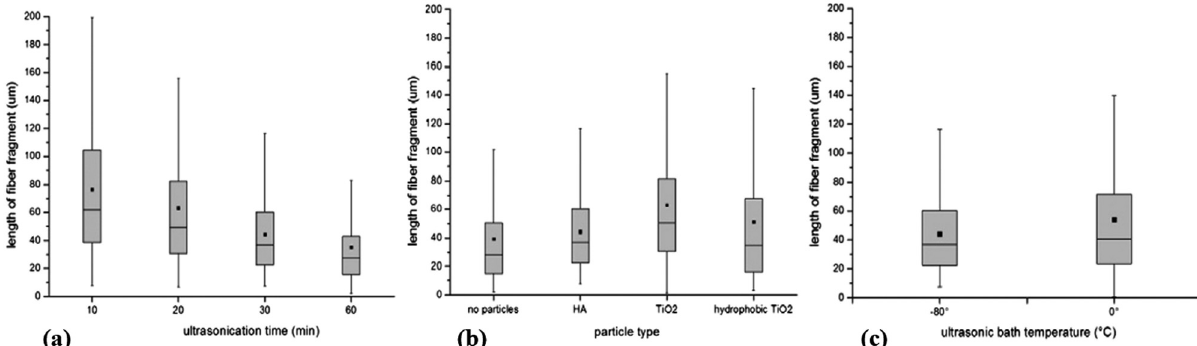
Figure 2: Fiber length distribution in relation to ( a ) sonication time and ( b ) nanoparticle type and ( c ) sonication bath temperature [ 105 ] ; Copyright 2014, reproduced with permission from Elsevier